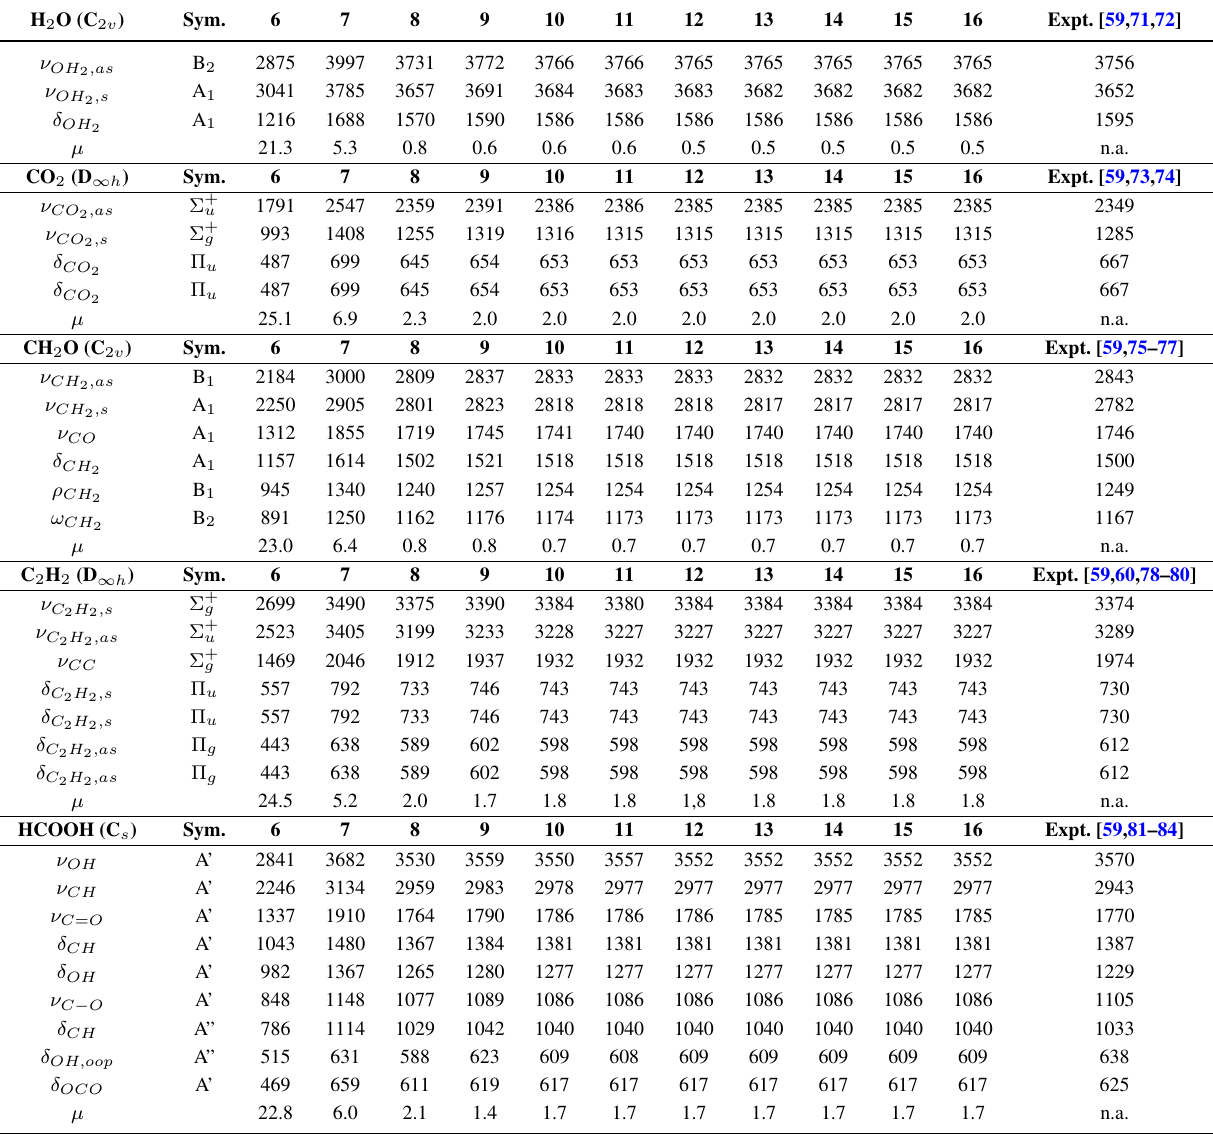
Table 1. Computed and experimental absorption data and the calculated values for µ in %. n.a. means “not applicable” and n.o. means “not